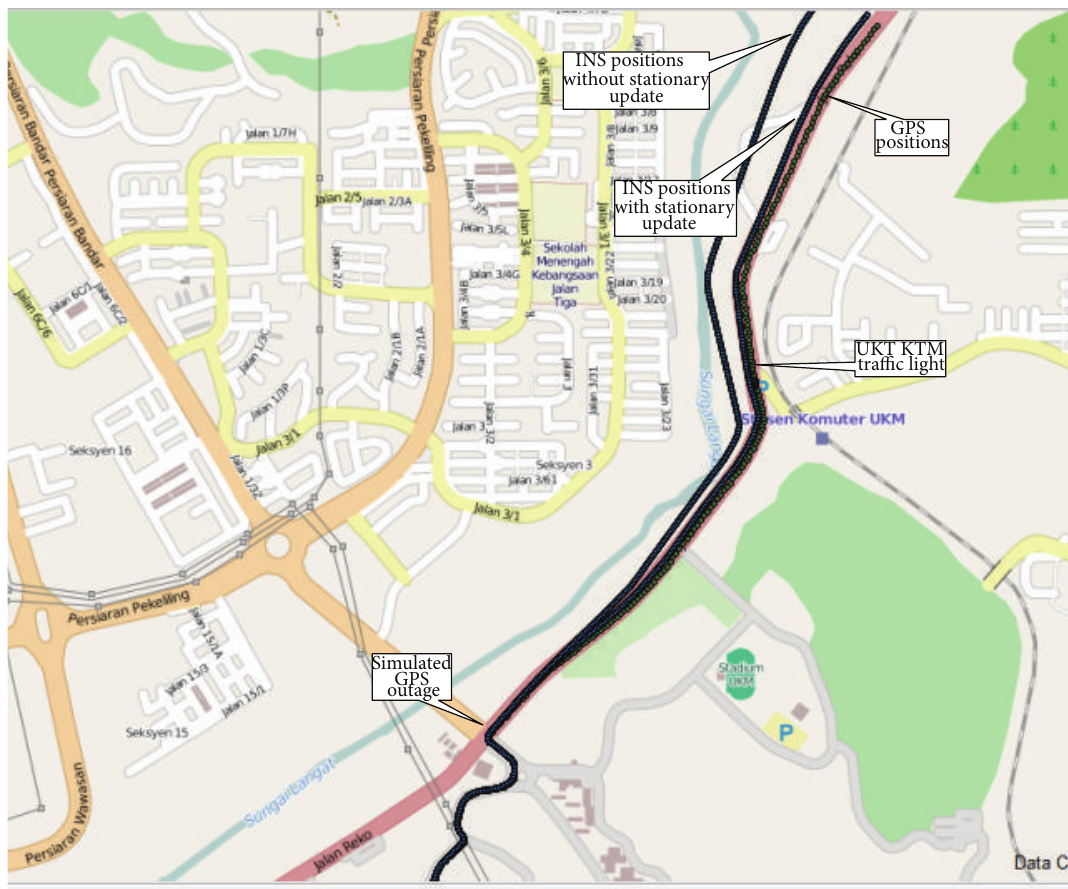
Figure 16: On vehicle performance test.